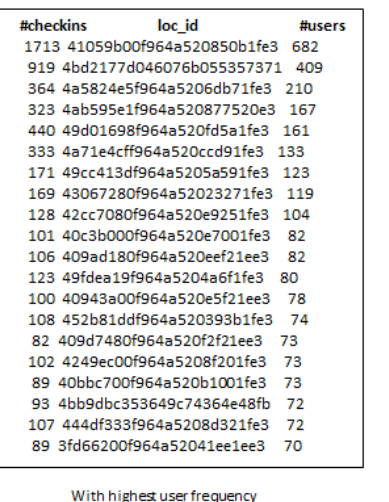
Figure 9. Top-20 influential locations across San Francisco using GIR algorithm.